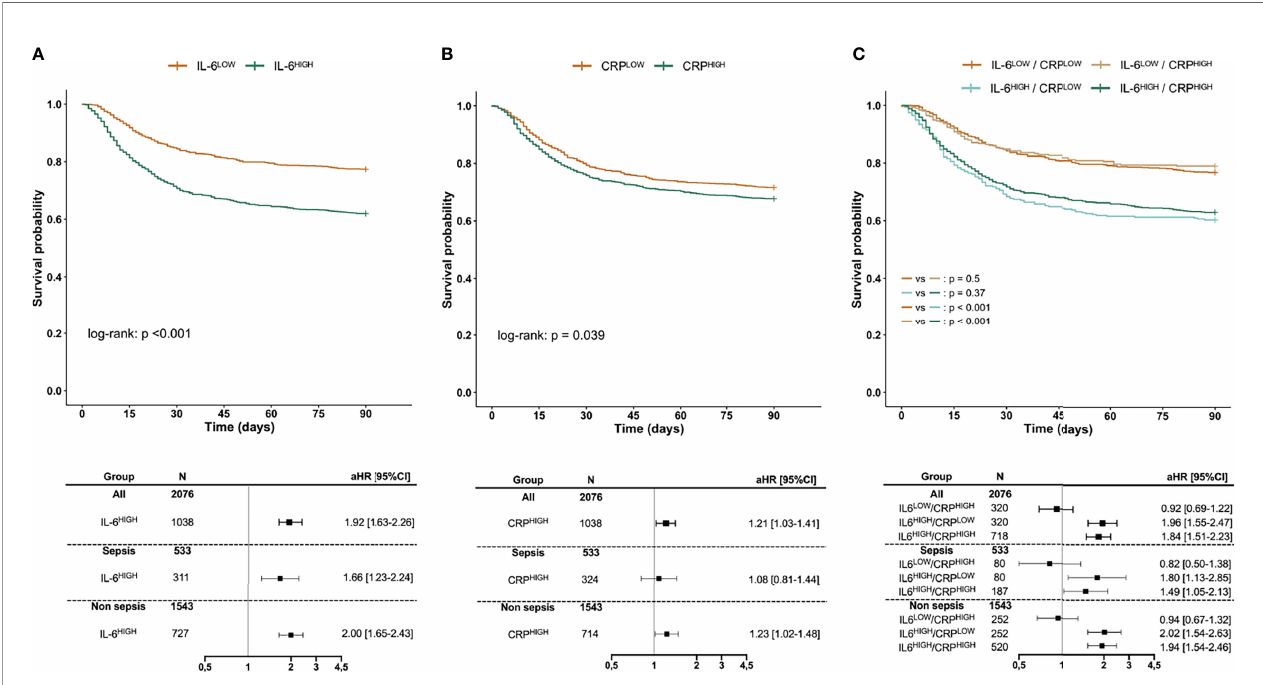
FIGURE 1 | Survival according to IL-6 (A) , CRP (B) , or both (C) . Kaplan – Meier survival curves according to the concentration of IL-6 (A) , CRP (B) , as well as in concordant or discordant subgroups (C) along with aHR estimated using Cox proportional hazard models. IL-6 HIGH and CRP HIGH are de fi ned as patients with biomarker over the respective median value. aHRs of day-90 mortality are given for the IL-6 HIGH group taking the IL-6 LOW group as the reference risk (A) , for the CRP HIGH group taking the CRP LOW group as the reference risk (B) , and for IL-6 LOW /CRP HIGH , IL-6 HIGH /CRP LOW , and IL-6 HIGH /CRP HIGH groups taking IL-6 LOW /CRP LOW as the reference risk (C) , after adjustment for SAPS-II. aHR, adjusted Hazard ratio; CI, Con fi dence interval; SAPS-II, Simpli fi ed Acute Physiology Score